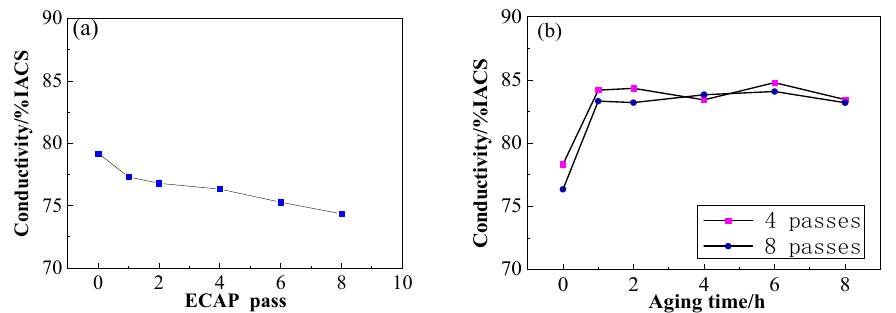
Figure 5. Electrical conductivity of Cu–1Cr–0.2Si alloy. ( a ) ECAP deformation of one to eight passes 216